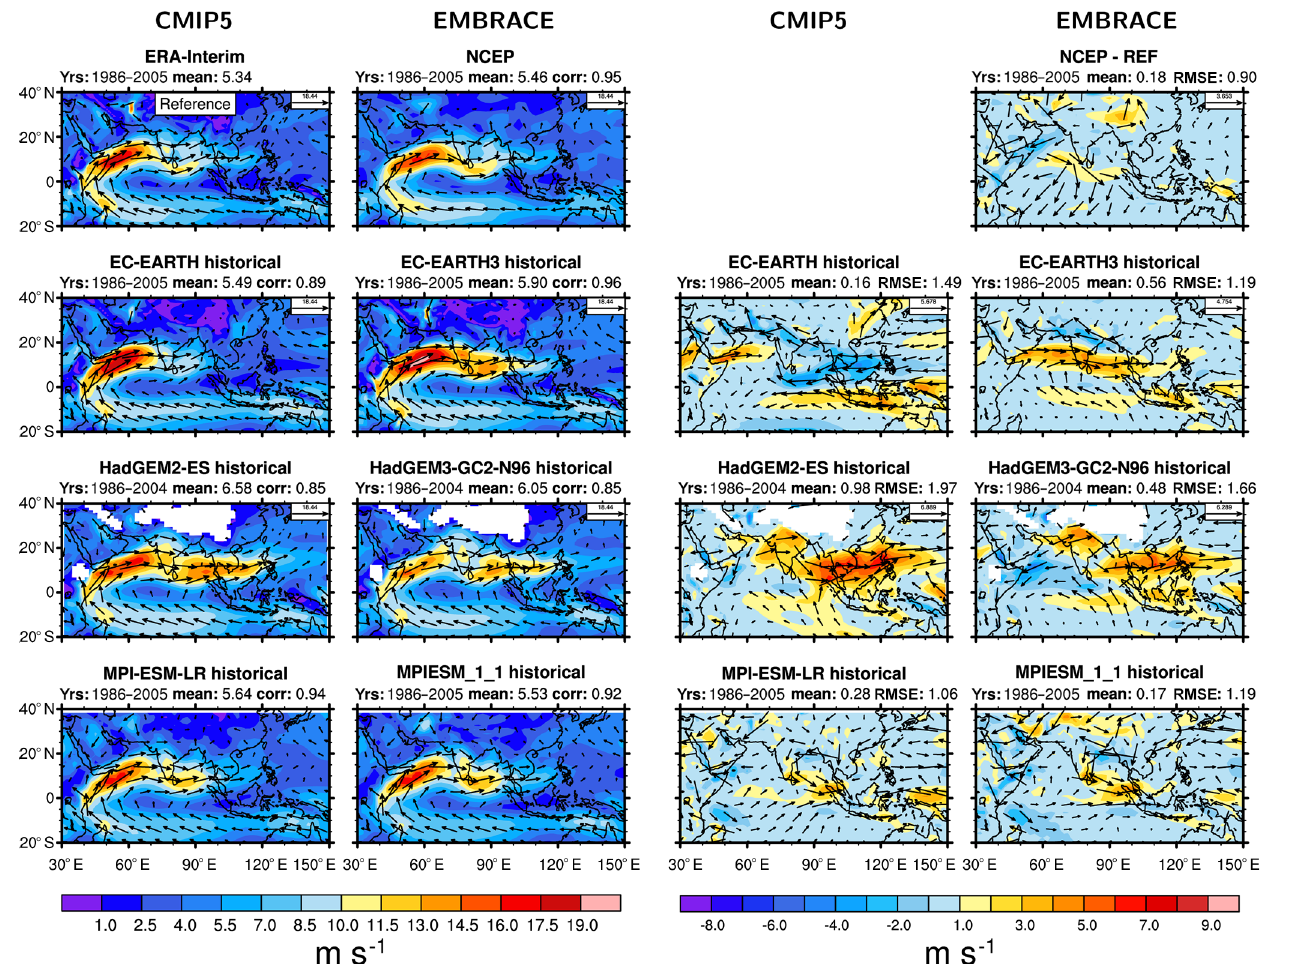
Figure 5. Leftmost two columns: seasonal mean zonal wind speed at 850hPa for JJAS from reanalysis data (ERA-Interim, NCEP 1) and the coupled simulations averaged over the years 1986–2005 (HadGEM: 1986–2004). Rightmost two columns: differences relative to ERA- Interim. Columns 1 and 3 show the original CMIP5 model versions, columns 2 and 4 the EMBRACE-updated models. The domain-averaged annual mean (“mean”), linear pattern correlation (“corr”; leftmost two columns), mean bias (“mean”), and root mean square error (RMSE; rightmost two columns) compared with ERA-Interim are given above the individual